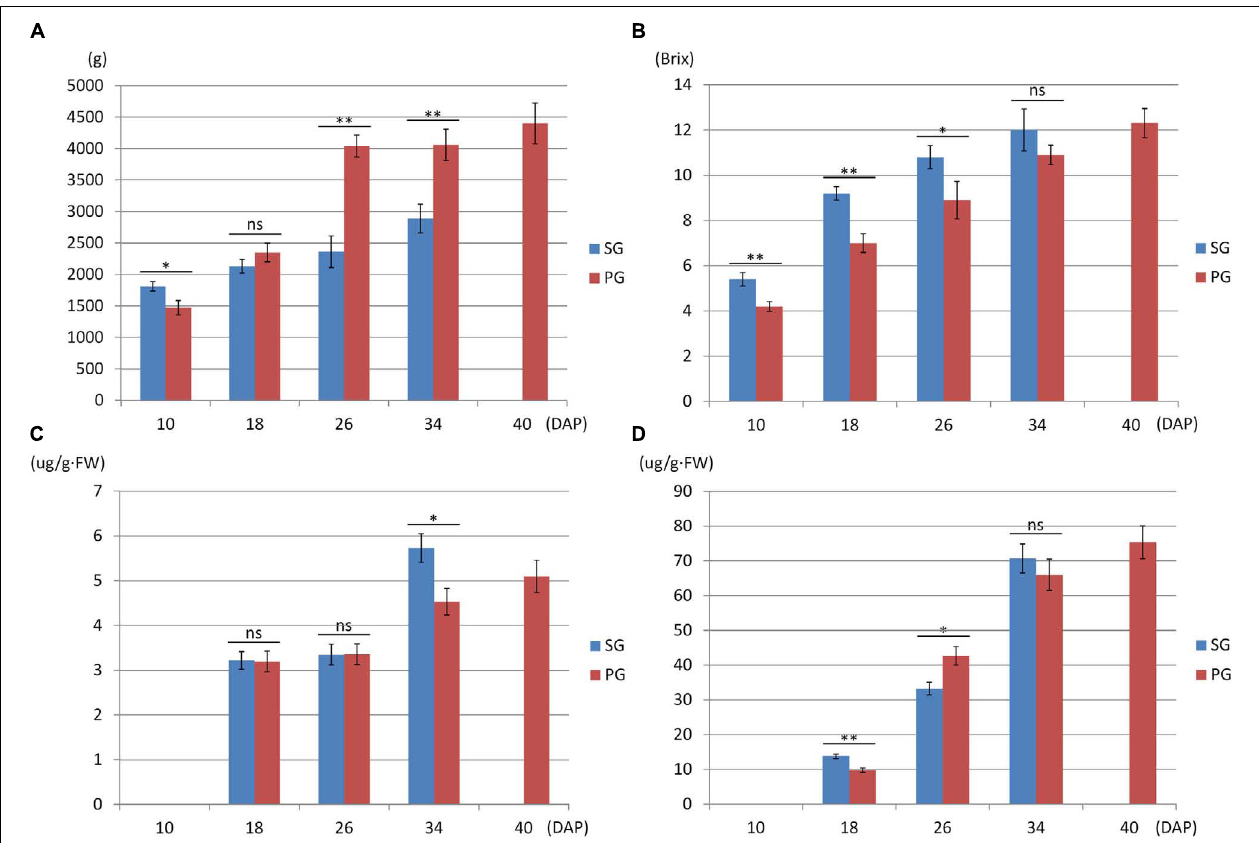
FIGURE 2 | Fruit phenotype comparison between watermelon self-grafted (SG) plant and pumpkin-grafted (PG) plant. (A) Fruit weight. (B) Fruit flesh sugar content. (C) Fruit flesh beta-carotene content. (D) Fruit flesh lycopene content. ns, not significant; * P < 0.05; ** P <